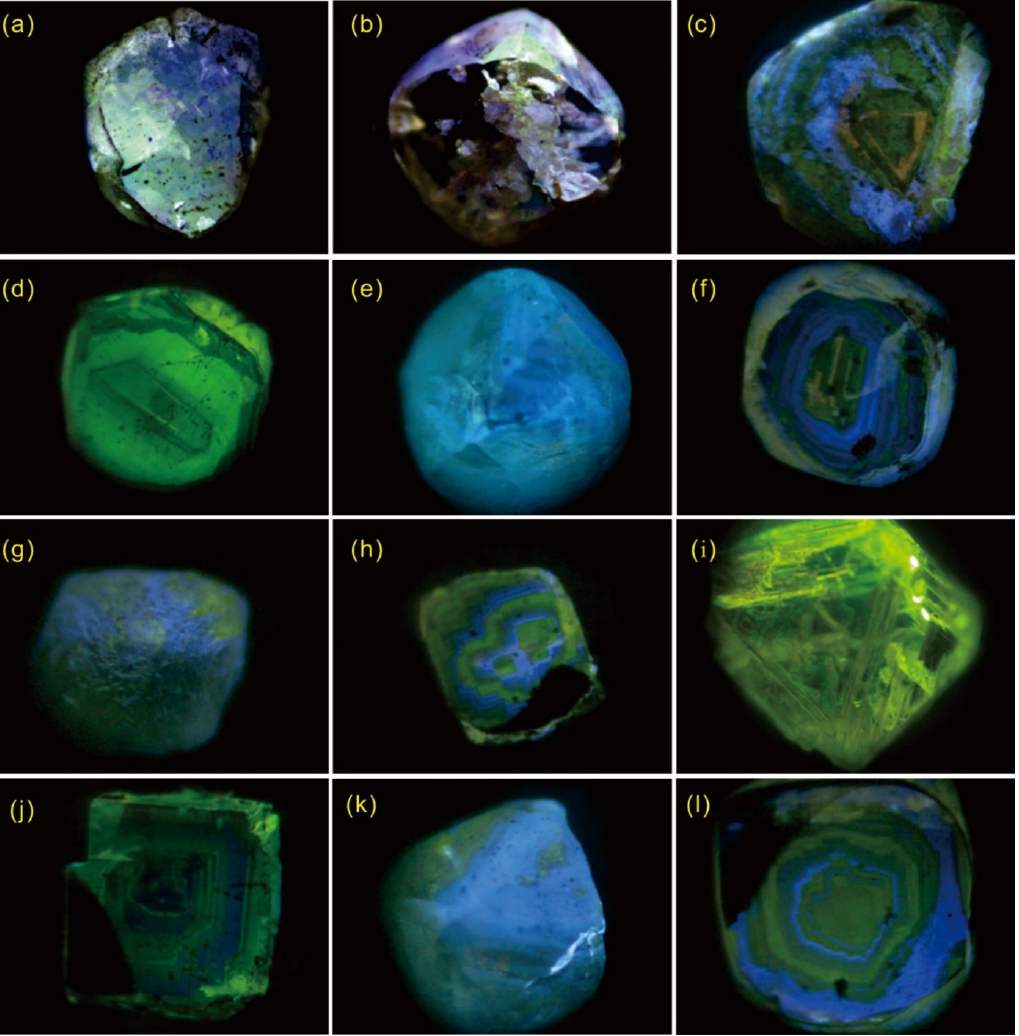
Figure 3. Cathodoluminescence features of brown diamonds from the Mengyin deposit. ( a ) Uncut sample DB5 showing purple and yellow-green luminescence; ( b ) Uncut sample DB3 dominantly showing purple; ( c ) Slice sample MY-38 has blue-violet, green, and tiny brown triangular growth-bands and mottled structure; ( d ) Slice sample MY-43-1 showing yellow-green with brown straight growth bands; ( e ) Uncut sample MY-40 is blue-green; ( f ) Slice sample MY-40 showing blue-violet, yellow-green agate-like growth bands; ( g ) Uncut sample MY-41 with a lilac luminous image; ( h ) Slice sample MY-41 exhibits yellow-green luminescence, and has blue ladder-like irreg- ular growth zonation; ( i ) Uncut sample MY-47 showing yellow-green luminous and triangular girdle; ( j ) Slice sample MY-47 mainly displaying green-blue agate-like growth zone; ( k ) Uncut sample MY-36 has blue-green luminescence; ( l ) Slice sample MY-36-1 mainly showing yel- low-green and blue, with an agate-like growth zone. 3.4. Infrared Spectrum Features The ability of infrared spectroscopy to identify the types of diamond and number of different chemical functional groups present at a surface in a nondestructive manner has contributed to its widespread application [38]. The position and classification of the in- frared absorption peaks of brown diamond from the Mengyin deposit are shown in Table S2. Except for samples MY-08, MY-25, and MY-46, the other 20 samples are shown more